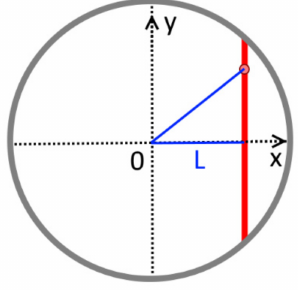
Figure 3. Obtaining the velocity profile of chord.